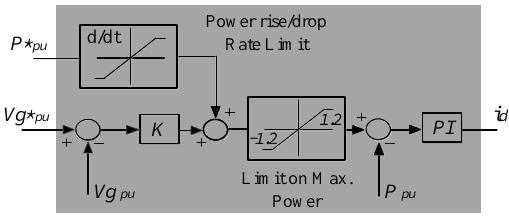
Figure 6. The DC droop controller.